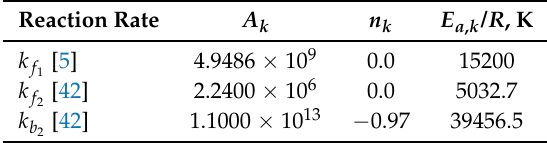
Table 3. Reaction rate constants for global reactions (17) and